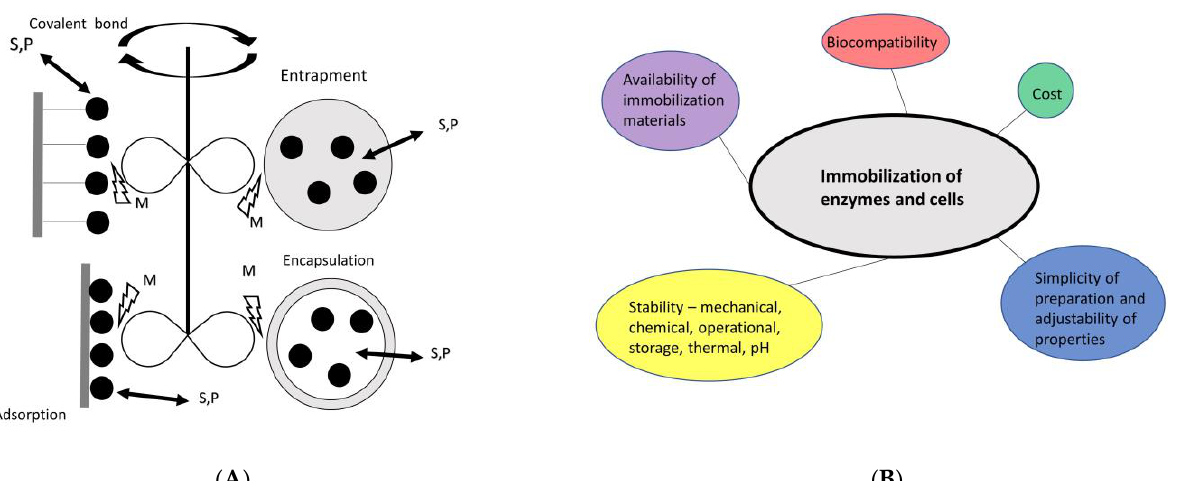
Figure 1. ( A ) Differences between immobilization techniques based on covalent bonding and adsorption (left) or entrapment and encapsulation (right) from the perspective of applied mechanical forces (M) in the bioreactor represented by a rotating impeller. Mechanical abrasion was applied directly on the adsorbed or covalently bond biocatalyst (left). Entrapment and encapsulation matrices protected biocatalysts from direct mechanical forces (right). The contact of immobilized biocatalysts with substrates (S) and products (P) was direct, using covalent bonding and adsorption as immobilization principles. Entrapment and encapsulation require diffusion of S and P through the immobilization matrix or the semipermeable membrane. ( B ) The five most important aspects for choosing the immobilization technique for